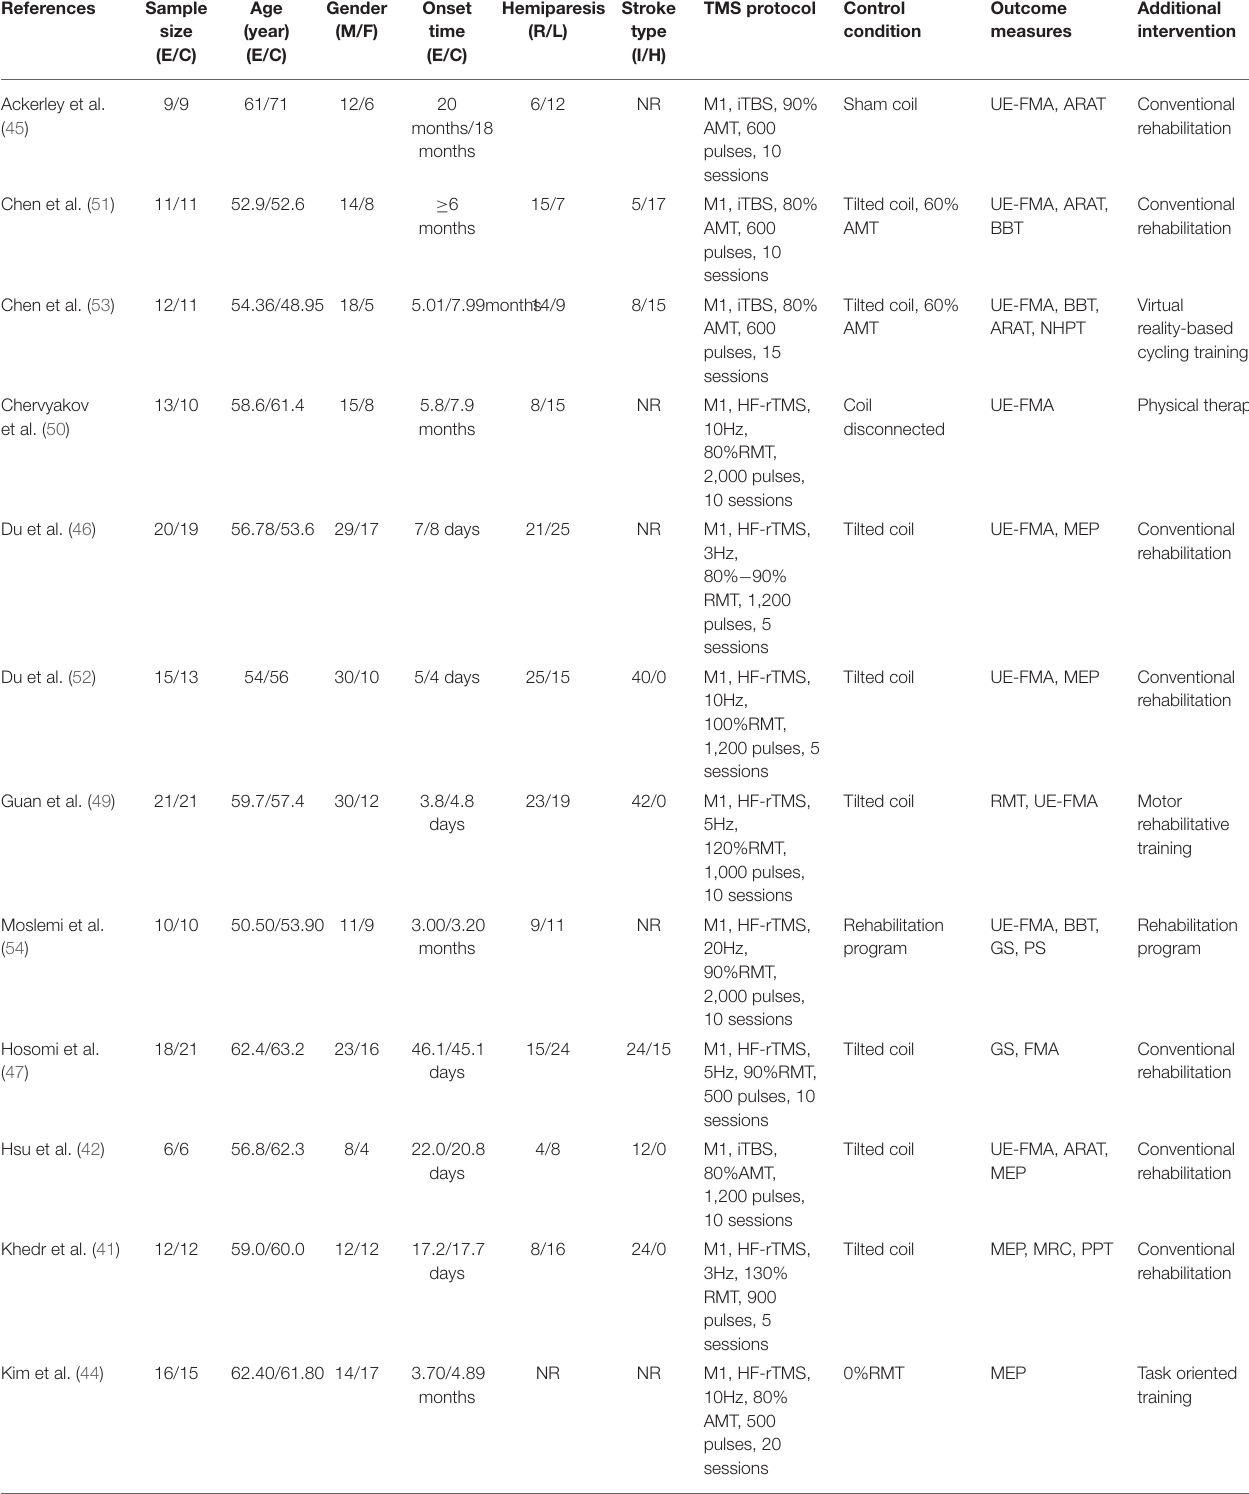
TABLE 1 | Characteristics of the included